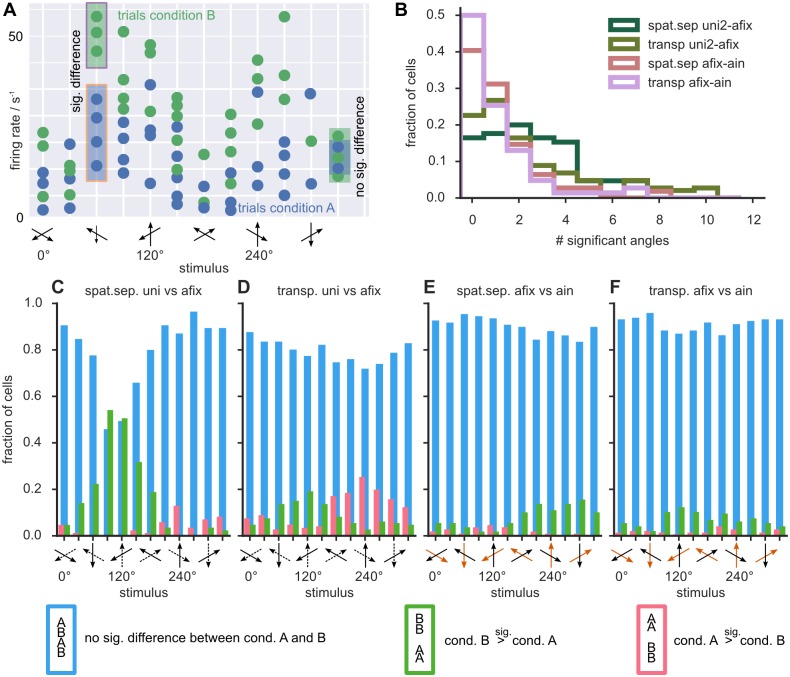
Effects of adding a second stimulus or attention to the receptive field.A) Each dot in this cartoon (not based on measured data) represents the observed spike count in one trial. For a given stimulus, spike count distributions can differ between experimental conditions either significantly (e. g. at 60°) or not (e. g. at 240°). B) Distribution of the proportion of cells with a significant difference between conditions for a given number of stimuli (maximum 12). The green histograms represent the two conditions where a second stimulus was added and pink histograms the conditions where attention was switched. C-F) Histograms show the stimulus-dependent fraction of cells with a non-significant response modulation (blue), a significant response enhancement (green) or response suppression (pink). The dotted and orange arrows along the x-axes in E and F indicate the RDP direction not present in the uni condition and the attended RDP in ain condition, respectively. Across the population a second stimulus tended to increase firing rates around 120°(C,D) and to decrease them around 240°. Attention asymmetrically affected the left and right peak in the spatially separated paradigm (E) whereas it symmetrically increased both peaks for the transparent paradigm (F). These stimulus-specific changes were compatible with the results of the direct method discussed in the text.